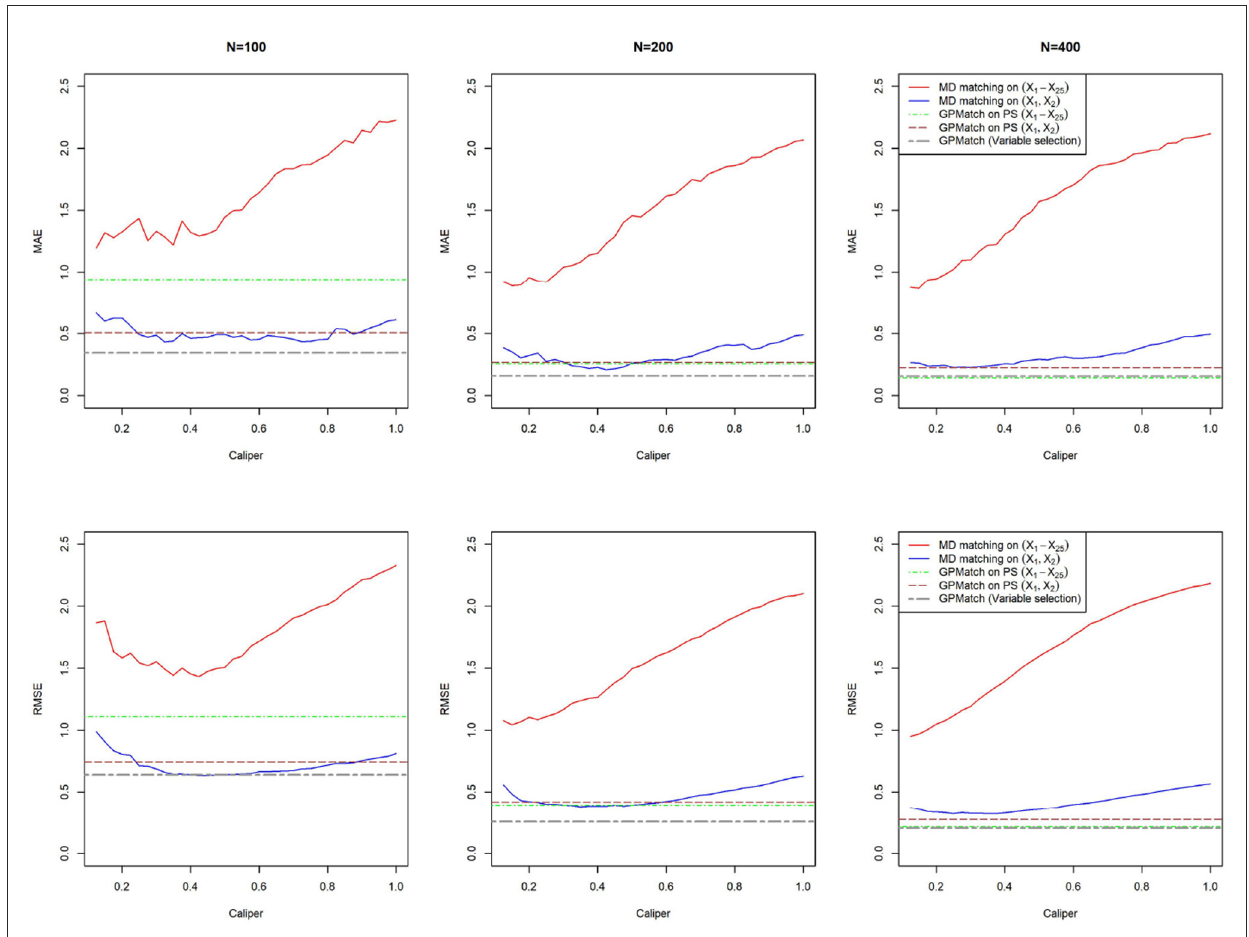
FIGURE4 Comparison of MAE and RMSE of Mahalanobis and GPMatch